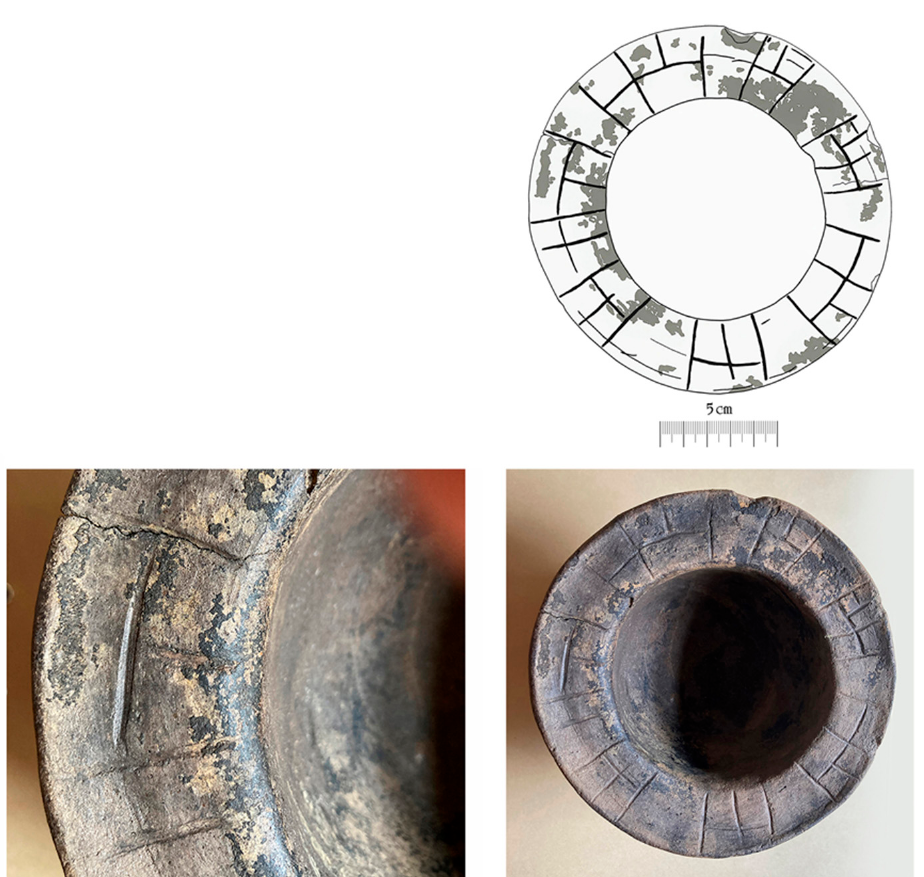
Figure 5. Dispersion of the soot marks on the rim and detailed views of the decoration and burnt marks.